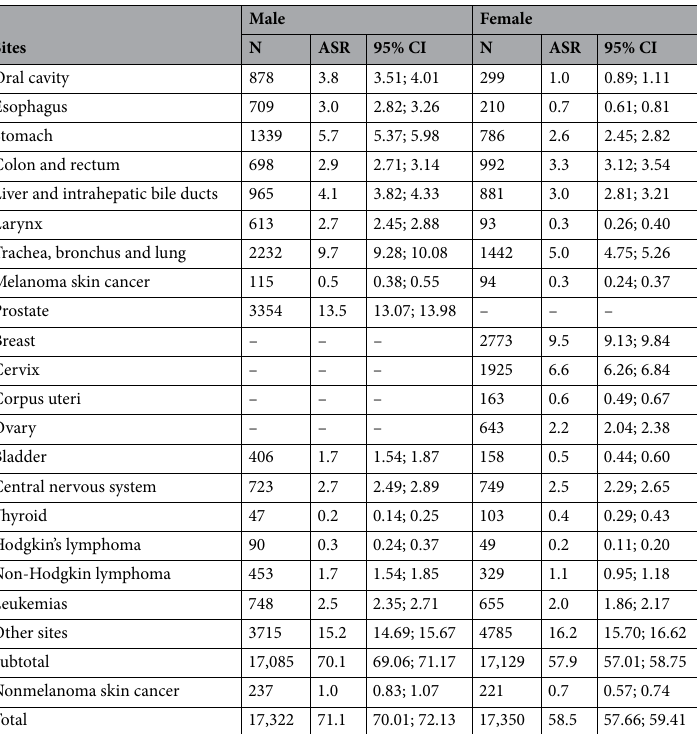
Table 1. Distribution of the number of cancer deaths (N) by the main sites, with respective age-standardized mortality rates (ASR) per 100,000 men and women and 95% confidence intervals (95% CI) in Sergipe,